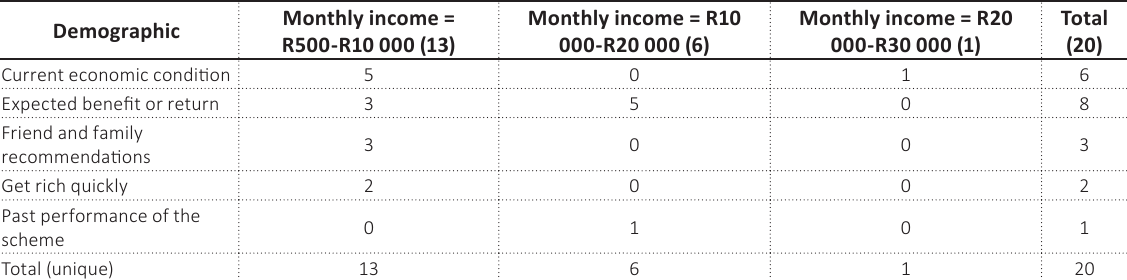
Table 5. Comparison of the monthly income and factors leading to the uptake of pyramid